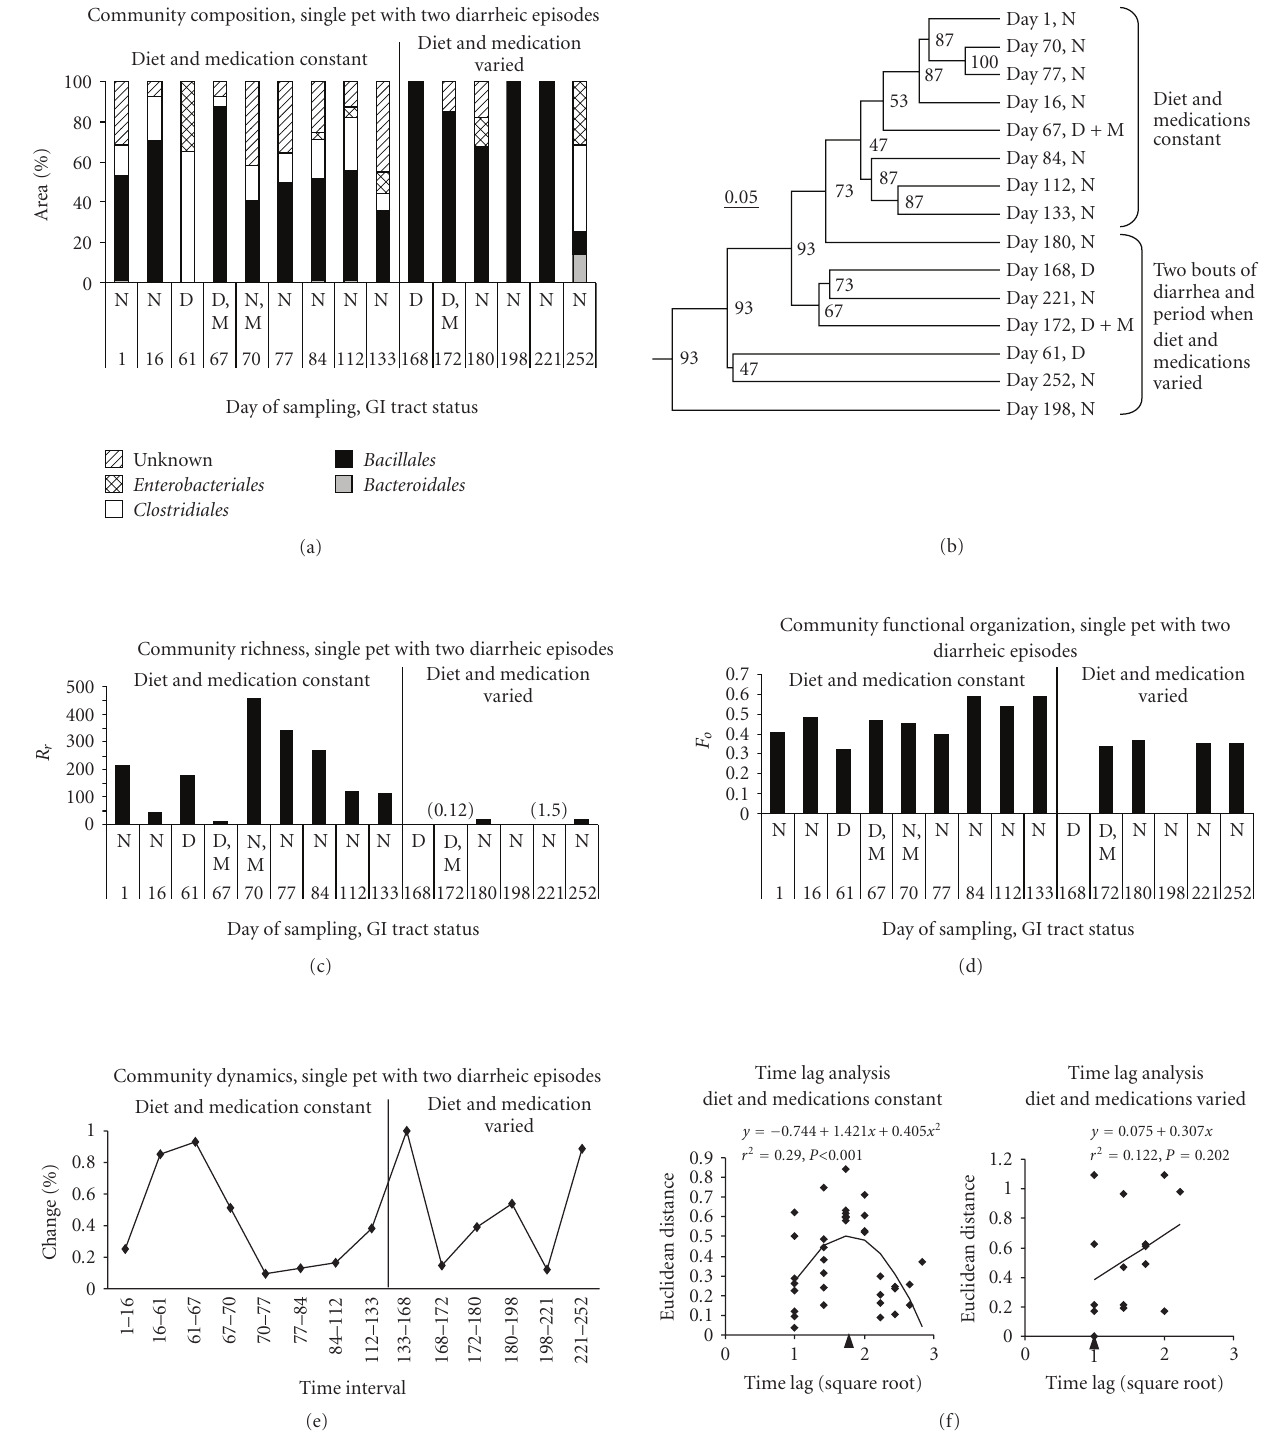
Figure 4: T-RFLP analysis of fecal samples from a single pet with two diarrheic episodes . Panel (a) community composition expressed as % area of peaks under the T-RFLP electropherogram; bacterial groups were combined at the taxonomic level of order. Panel (b) dendrogram based on Bray-Curtis similarities of community composition among the samples from this dog; numbers at nodes indicate percentage of trees having an equivalent node in jackknife analysis. Panel (c) community richness parameter, Rr . However, Rr is not reported when there was only a single peak ≥ 1% of the area under the electropherogram (days 168 and 198); the value of Rr was 0.12 on day 172 and 1.5 on day 221. Panel (d) community functional organization, Fo . However, Fo is not reported when there was only a single peak ≥ 1% of the area under the electropherogram (days 168 and 198). Panel (e) % change parameter for community dynamics. Panel (f) time lag analysis. Arrows below the X -axis indicate the day of onset of an episode of